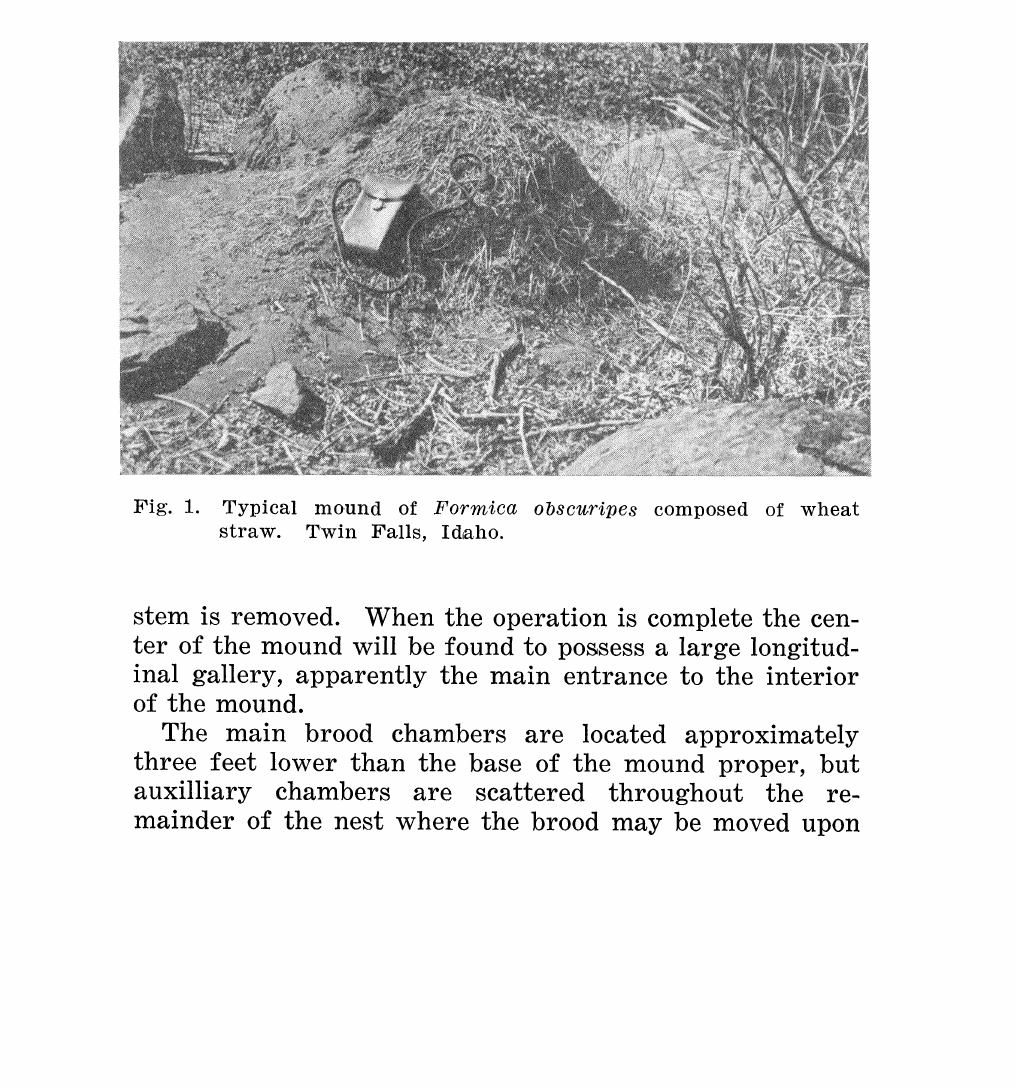
Fig. 1. Typical mo.und of Formica obscuripes composed of wheat straw. Twin Falls,